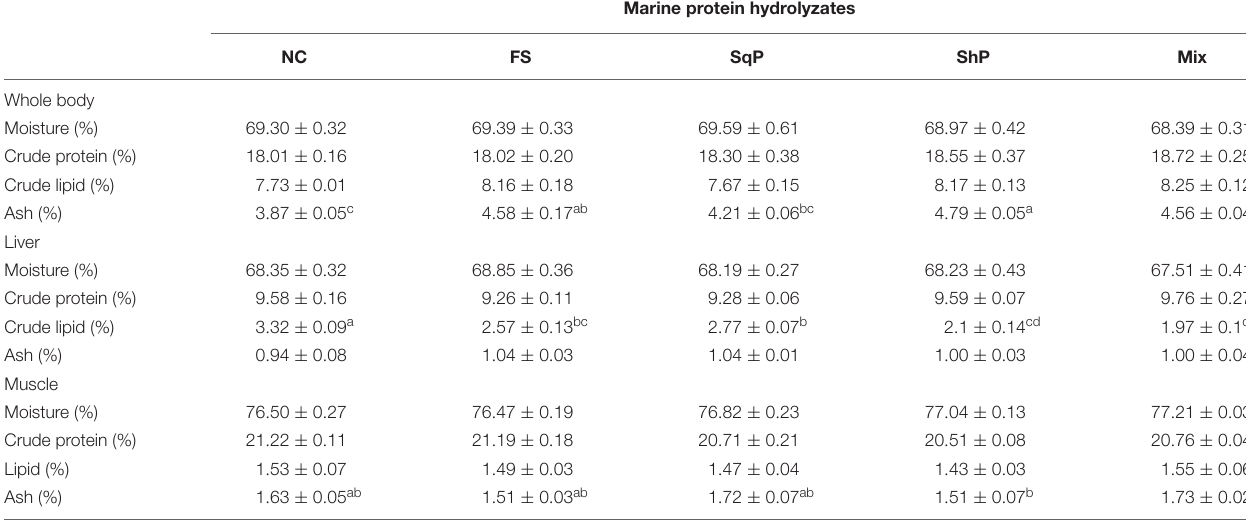
TABLE 6 | Whole-body, liver proximate composition, and muscle proximate composition of largemouth bass fed the experimental diets for 81 days*. Marine protein hydrolyzates